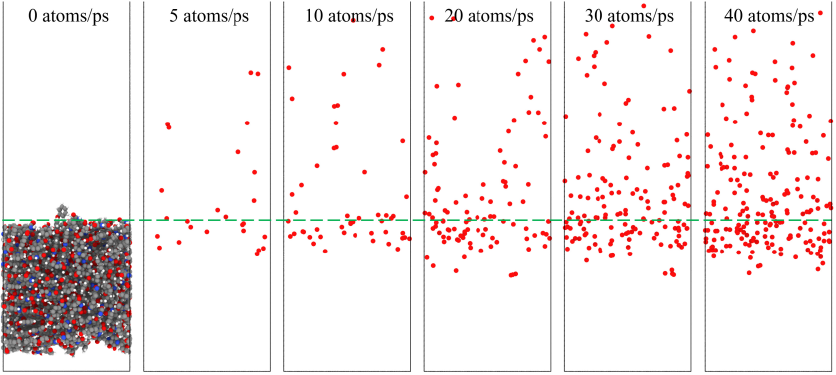
Figure 27. Snapshots of atomic oxygen trajectories at different dose rates in the initial phase (5 ps).